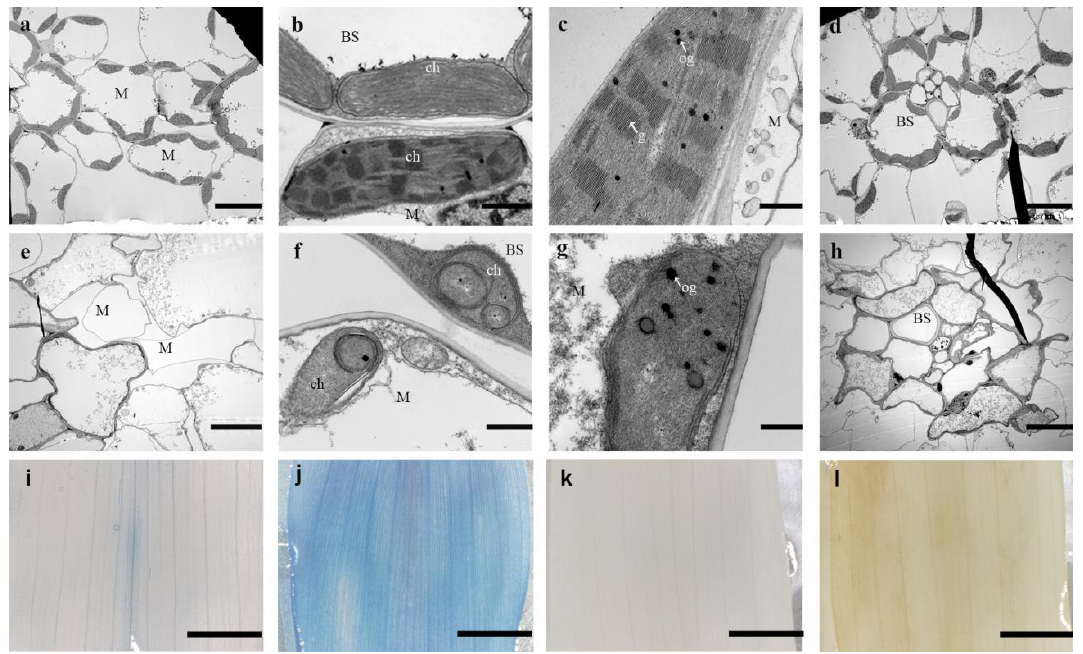
Figure 2. Electron microscopy observations of as-81647. ( a , e ) The number of chloroplasts per unit area in WT ( a ) and as-81647 ( e ) plants. ( b , f ) Chloroplast structure in mesophyll cells and vascular bundle sheath cells in WT ( b ) and as-81647 ( f ) plants. ( c , g ) Comparison of chloroplast structure between WT ( c ) and as-81647 ( g ) plants. ( d , h ) Granum structure in WT ( d ) and as-81647 ( h ) plants. M Mesophyll cell, BS Bundle sheath cells, ch chloroplasts, g granum thylakoid, og osmiophilic globule. Bar = 1 µ m ( b , c , f , g ) and bar = 10 µ m ( a , e , d , h ). ( i , j ) DAB staining of WT ( i ) and as-81647 ( j ) leaves. ( k , l ) Trypan blue staining of WT and as-81647 leaves. Bar = 1 cm. Table 1. Segregation of leaf color in the F 2